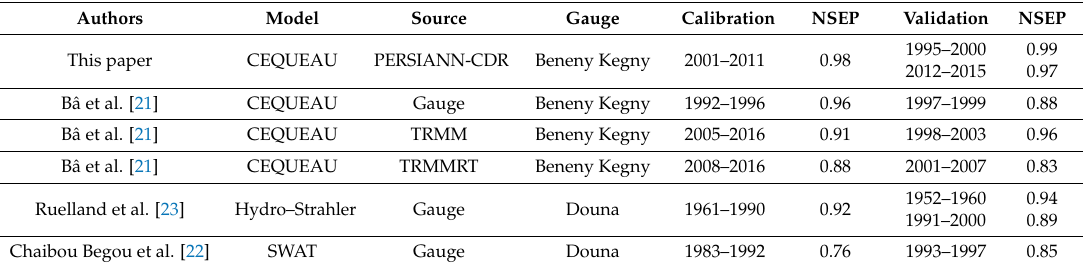
Table 8. Comparison with other studies conducted over the Bani basin.